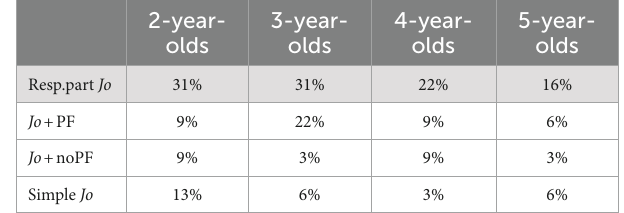
TABLE 4 Productions of the sentence-initial response particle jo by age group ( N = 32).